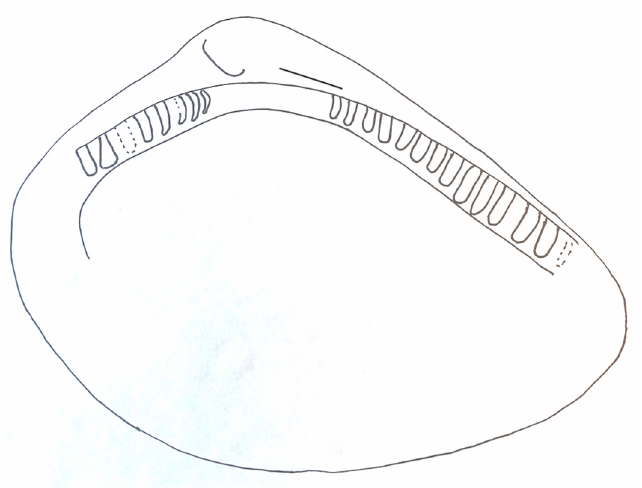
Figure 6. Nuculanoid clam fossil (IGM 5010a). Line art sketch of interior view of left valve, showing wide hinge plate, external ligament groove and taxodont dentition. Greatest dimension of shell: 7 mm.